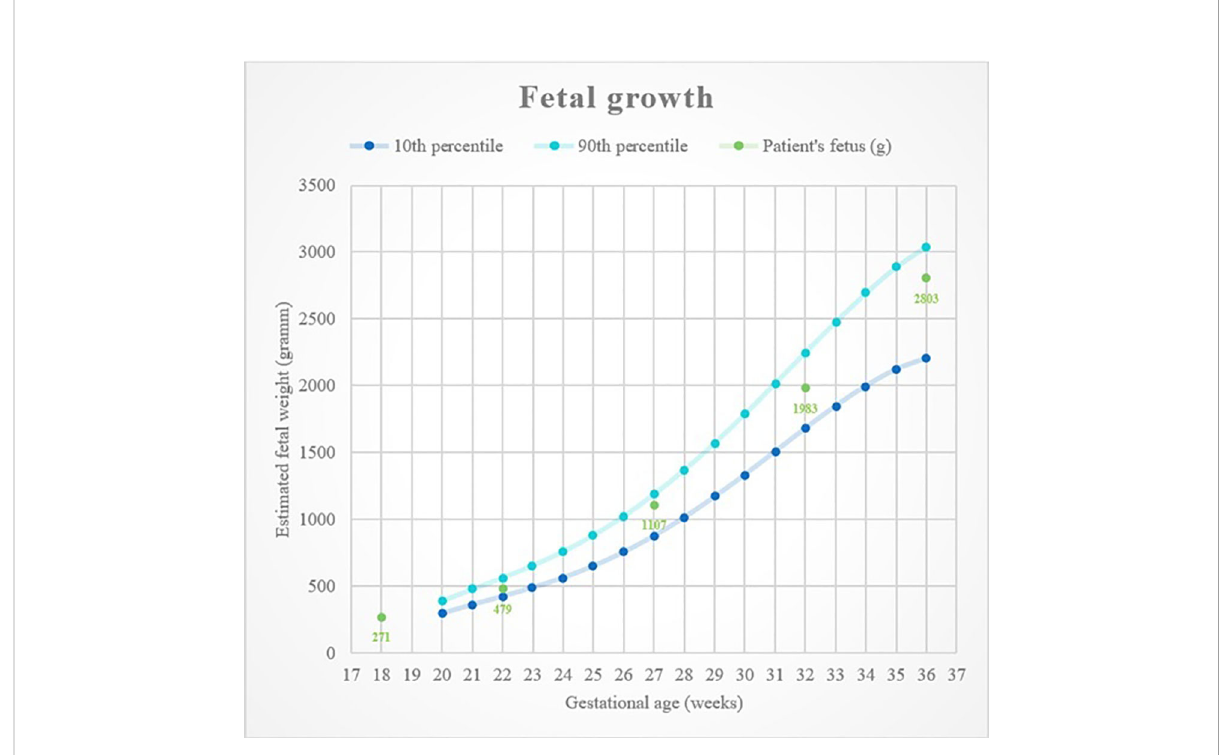
FIGURE 1 Fetal growth with percentile